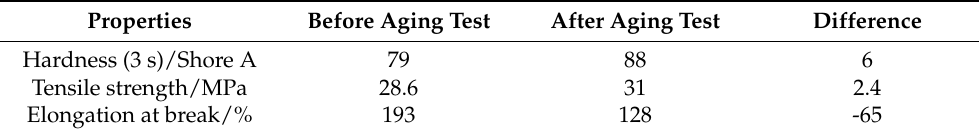
Table 2. Mechanical properties of the HXNBR compound before and after aging.